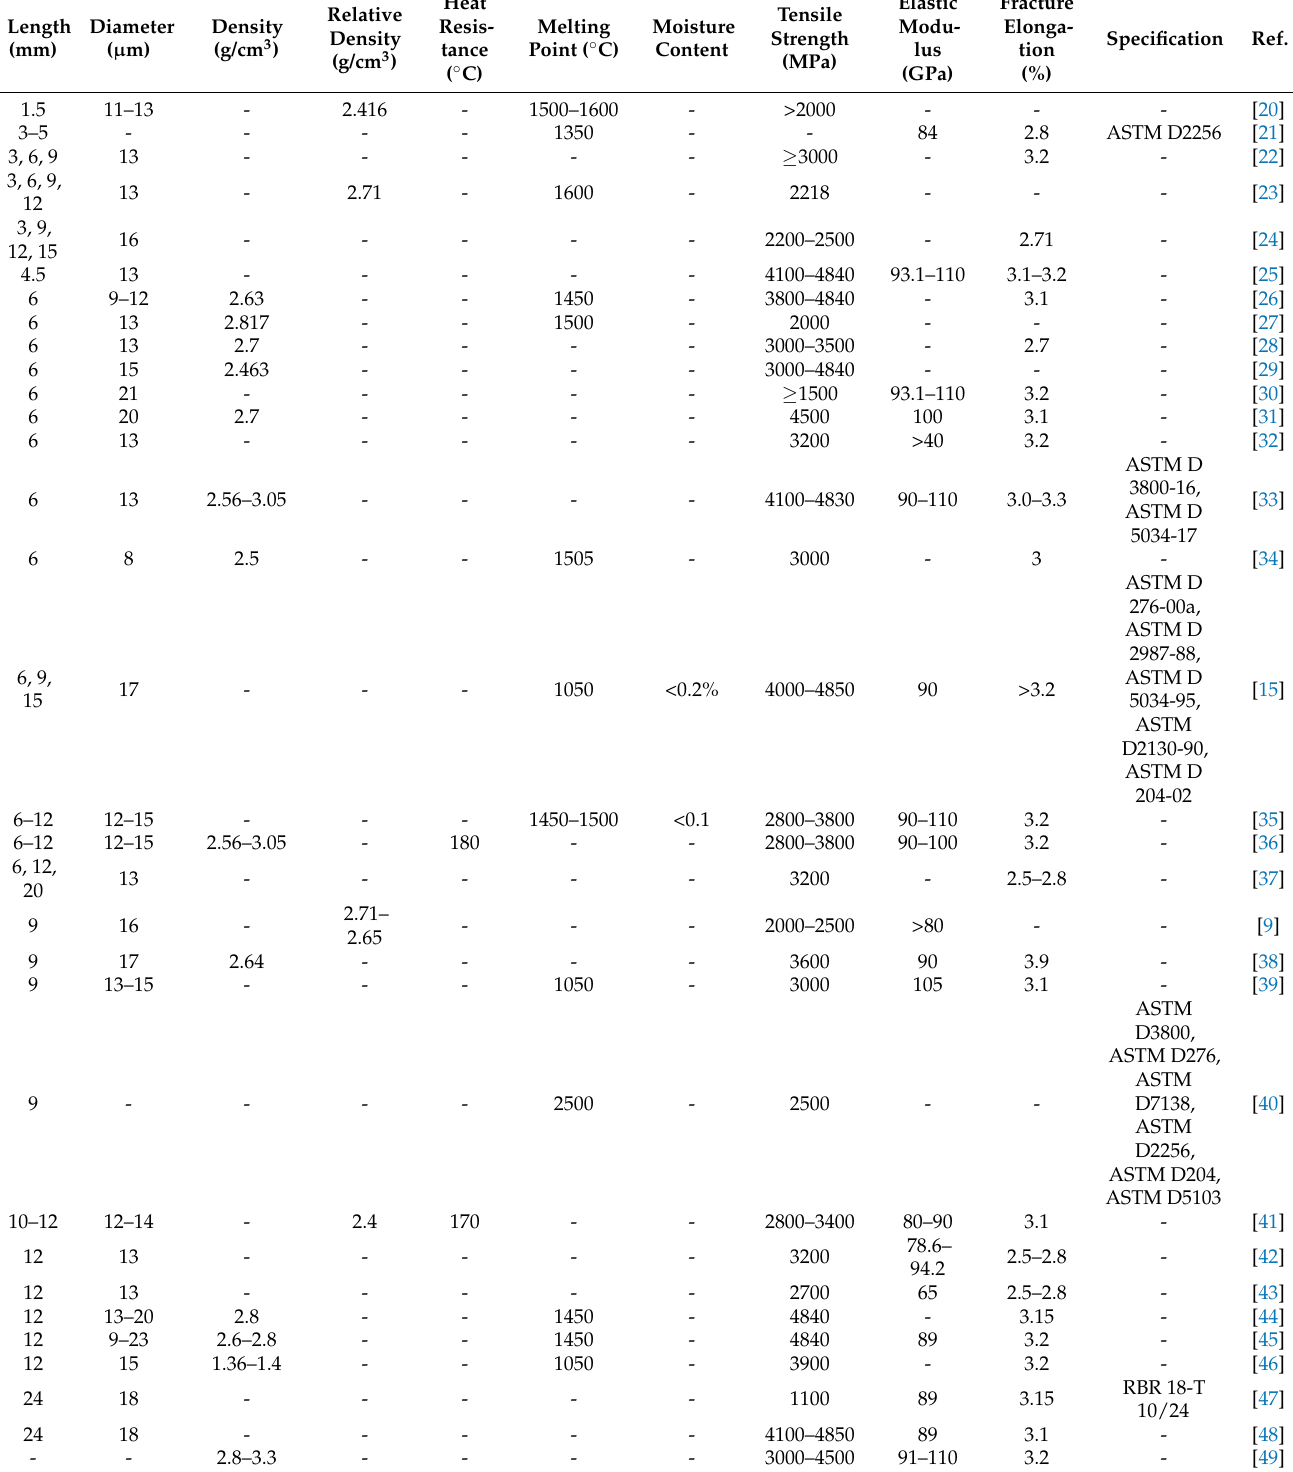
Table 1. Basic properties of basalt fiber in asphalt